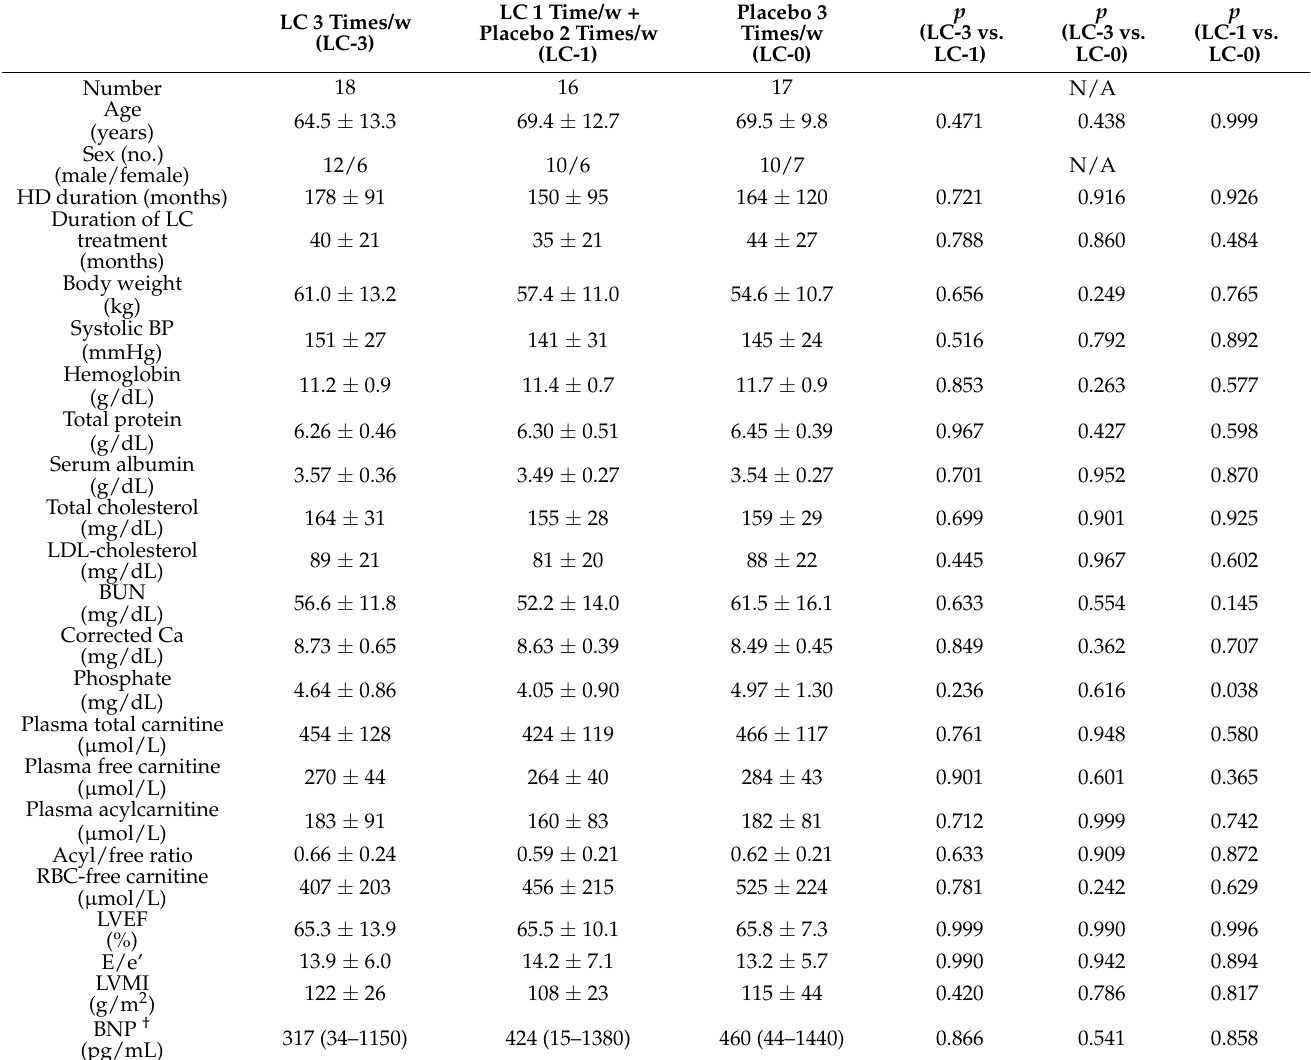
Table 1. Clinical characteristics at